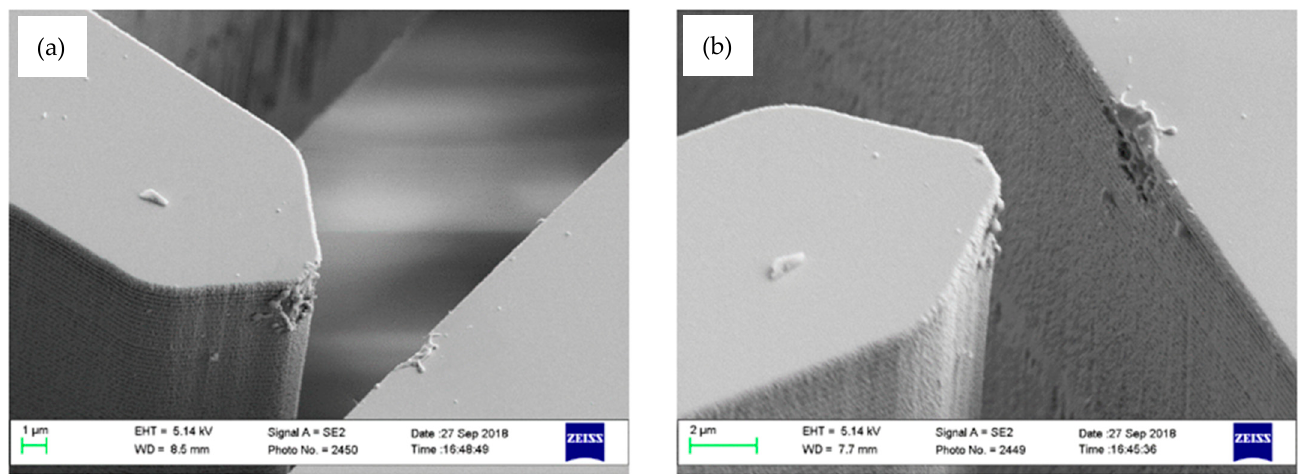
Figure 13. Pull out ( a ) and pull in ( b ) images for MEMS 3. ( c ) A sample hysteresis plot.